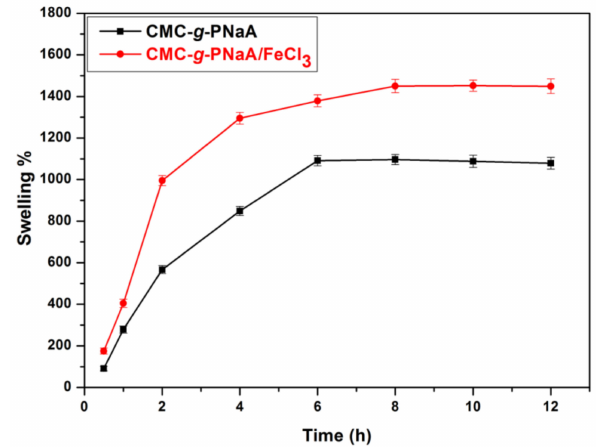
Figure 7. Swelling behavior of CMC- g -PNaA and CMC- g -PNaA / FeCl 3 hydrogel